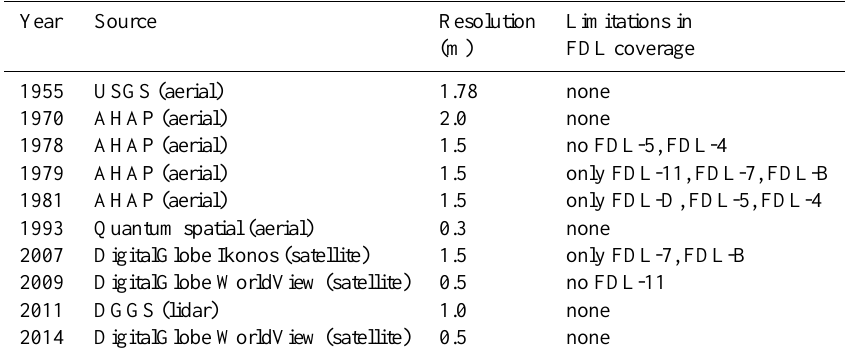
Table 1. Summary of available imagery used for historic analysis. USGS is the US Geological Survey, AHAP stands for Alaska High- Altitude Photography, and DGGS is the Alaska Division of Geological&Geophysical Surveys. If all FDLs are covered by a given data set, “none” is stated under